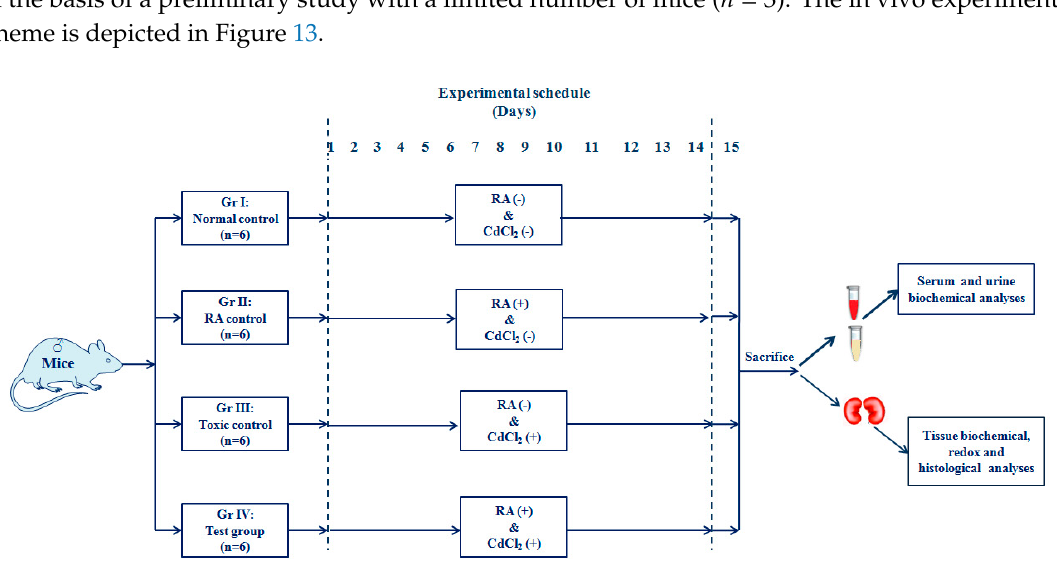
Figure 13. A schematic impression of in vivo experimental protocol.